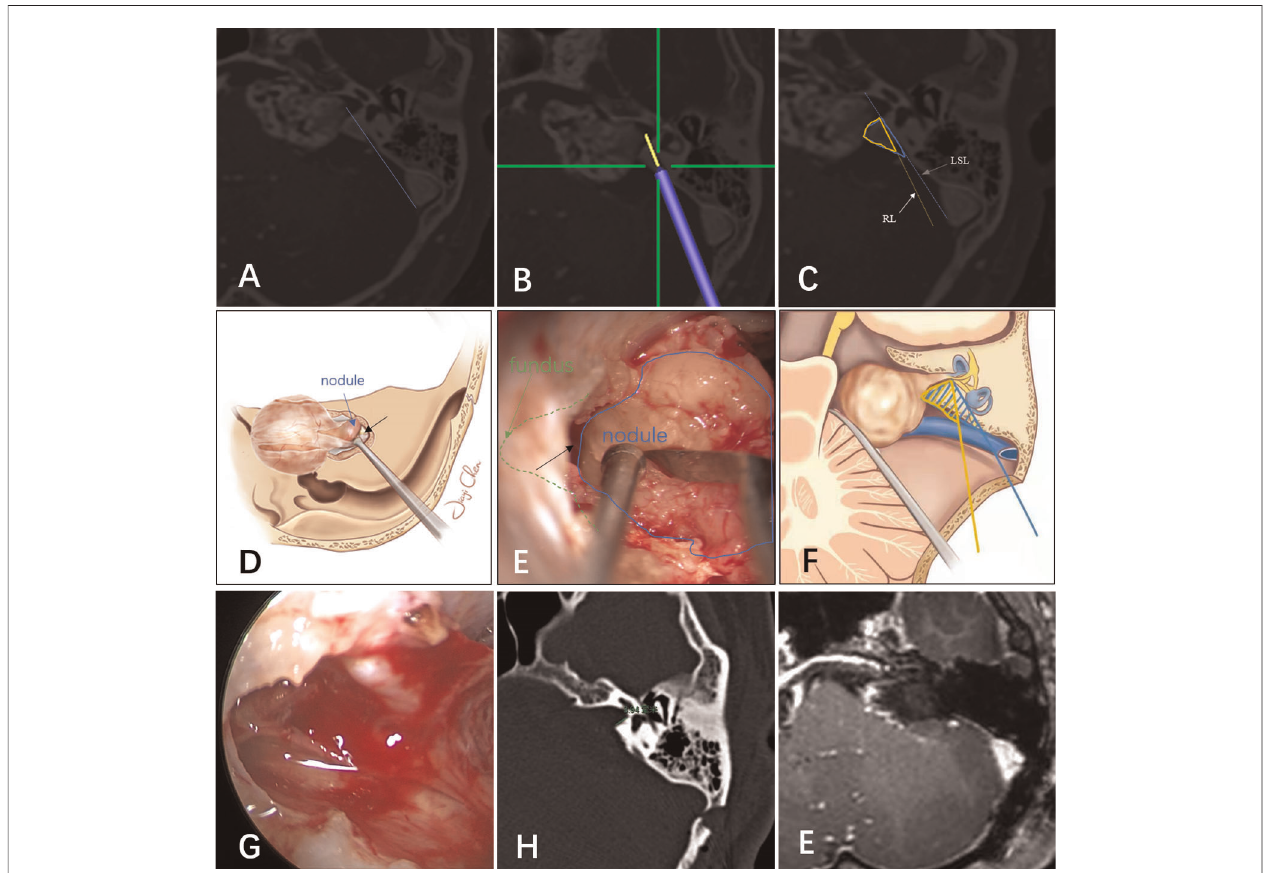
FIGURE 3 | ( A ) The tumor was classi fi ed as lateral based on magnetic resonance imaging and computed tomography fusion images. ( B ) Navigation predicted the resection line. The yellow line extending from the tip of the navigation pointer is the predicted resection line. ( C , F ) Illustration of the lateral safe line (blue line) and resection line (yellow line). Illustrative drawing ( D ) and microscopic view ( E ): the intrameatal portion of the tumor is displayed as a nodule (blue). The interface (black arrow) between the tumor (blue) and fundus (green) was visible by gently pulling the tumor medially. This means that the opening of the IAC was adequate. ( G ) Endoscopic examination showed no residual tumor, and the capsule near the nerves was retained. Postoperative CT( H ) and MR( I ) showed no tumor residue and the labyrinth was